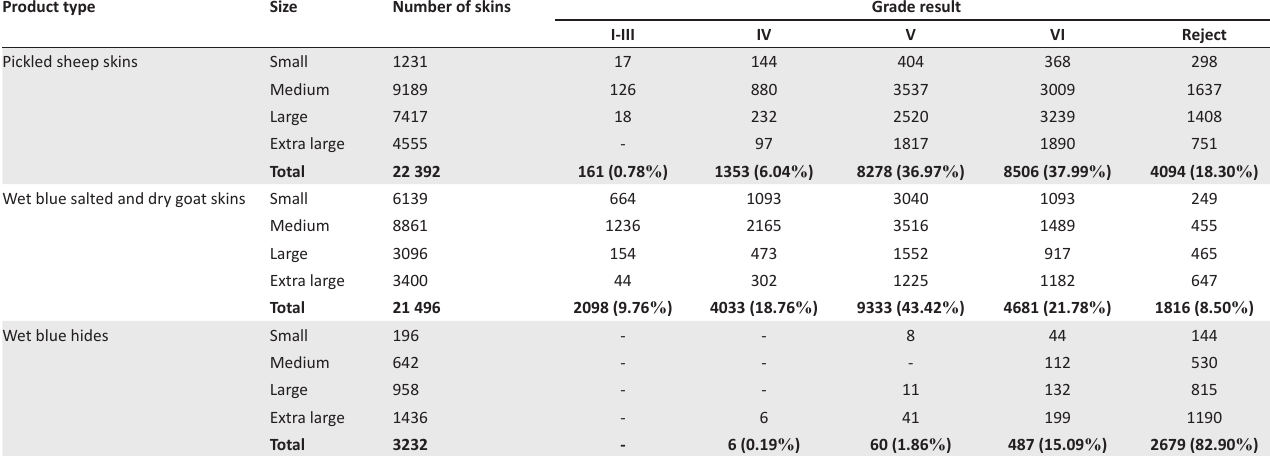
TABLE 4: Quality grade of semi-processed skins and hides at the Sheba Tannery and Leather Industry, Tigray, Ethiopia. Product type Size Number of skins Pickled sheep